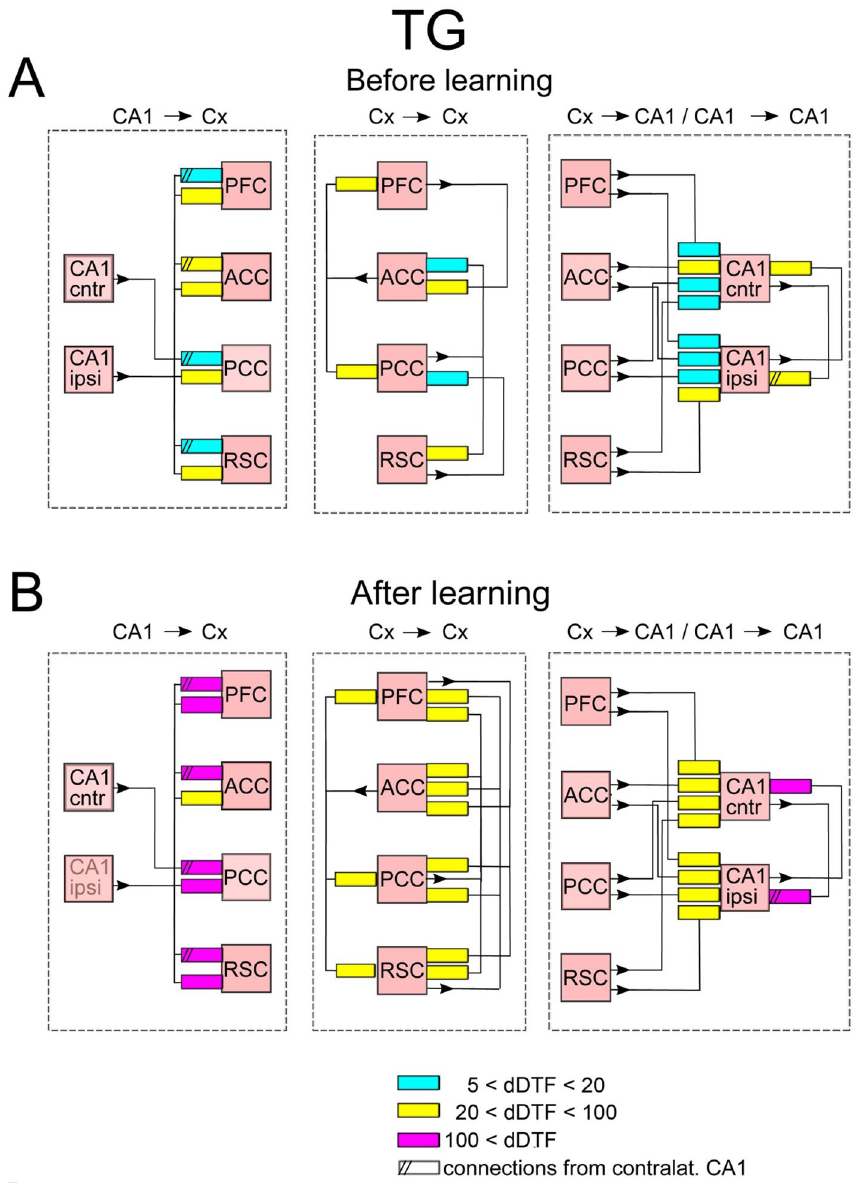
Figure 5. Scheme of coupling between brain structures in TG mice during SWRs, before learning and after learning. Notice extensive interaction between all structures which is even strengthen after learning session. The organization of the picture as in Fig.